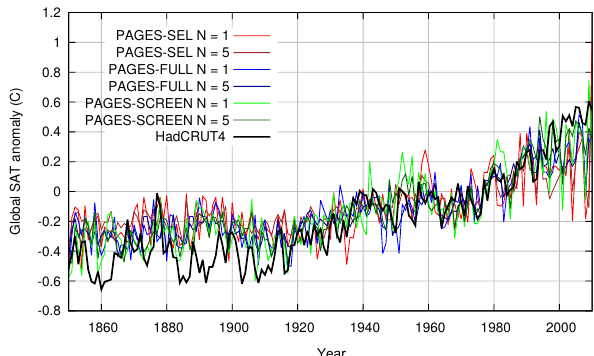
Figure 10. Time series of globally averaged SAT anomalies with respect to the period 1961–1990. The bold black line represents the infilled HadCRUT4 dataset, whereas colours indicate six recon- structions based on N = 1 , 5 in Eq. (2) using the RMSE-AM ver- sion with the three variants of the PAGES 2k network described in Sect.